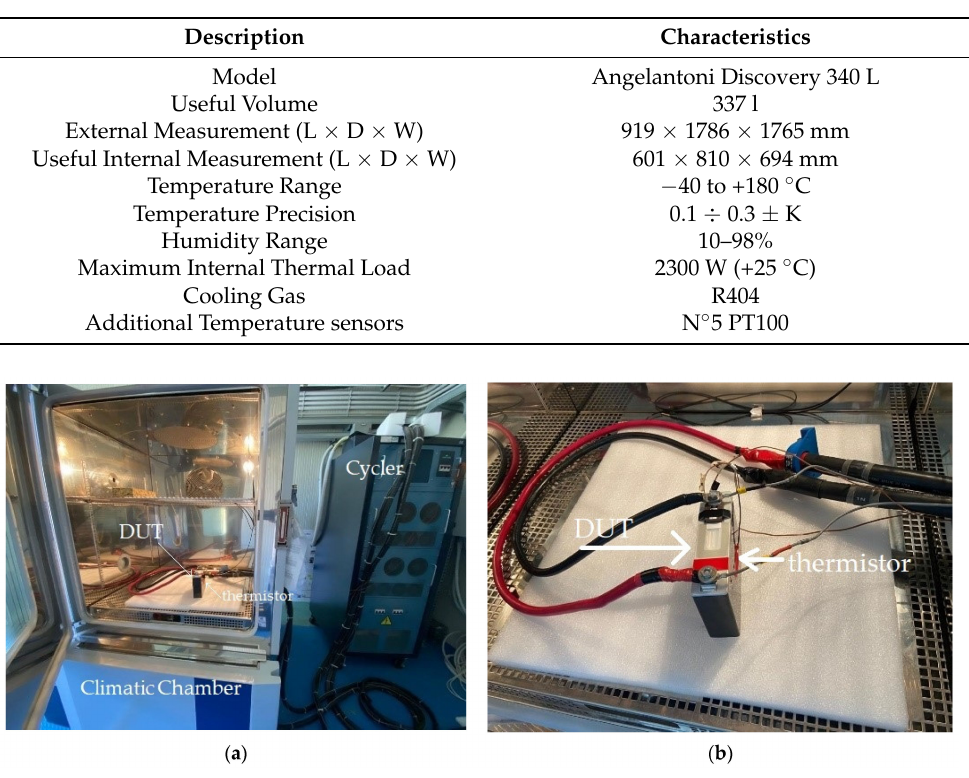
Table 7. Climatic chamber main features.